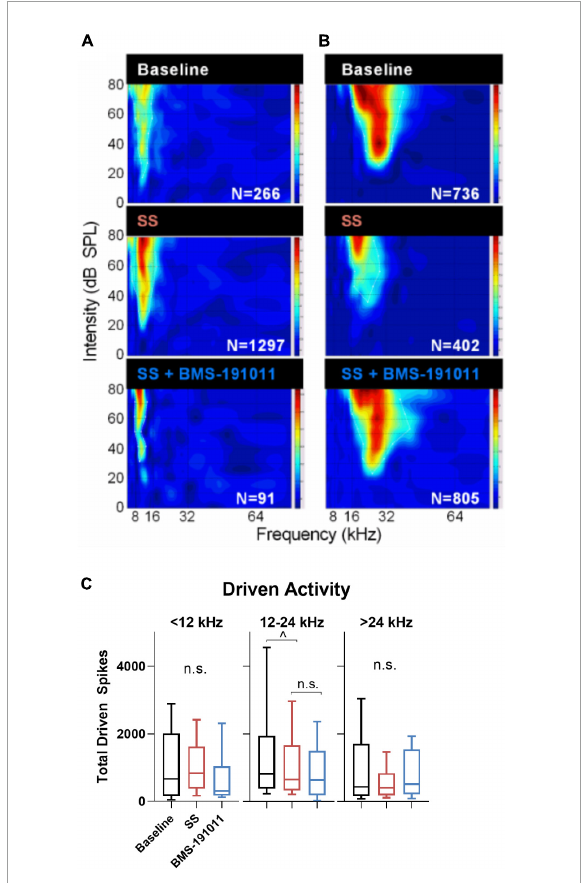
FIGURE5 Changes in evoked activity occurred in some, but not all IC units following SS and BMS-191011 administration. (A,B) Representative recordings are shown for two units in the IC. eFRAs are shown for baseline, the day after SS administration, and again after BMS-191011 administration. Spike counts (Ns) were measured within the excitatory boundaries of the eFRA and reported at each timepoint. Some lower frequency units showed an increase in activity following SS administration that was subsequently suppressed by BMS-191011 application. Some mid-to-high frequency units showed decreases in activity following SS administration that was recovered following BMS-191011 application. Neither pattern was consistent enough to drive significantly changes in mean driven activity. (C) Plots of mean total driven spike counts measured from the eFRAs at baseline (black), the day after SS administration (orange), and again after BMS-191011 administration (blue). One-way ANOVAs did not show clear effects of treatment. The one-way ANOVA was not significant for units with BFs ≤ 12 kHz or > 24 kHz ( F (2,194) = 1.362; p = 0.26; F (2,175) = 2.397; p = 0.09). The one-way was significant for units with mid-range BFs ( F (2,181) = 4.140; p = 0.0175), but this appeared to be driven predominantly by effects of SS, but not BMS-191011. Additionally, subsequent Holms-Sidak post-hoc analyses did not show significant differences between time points for these mid-range